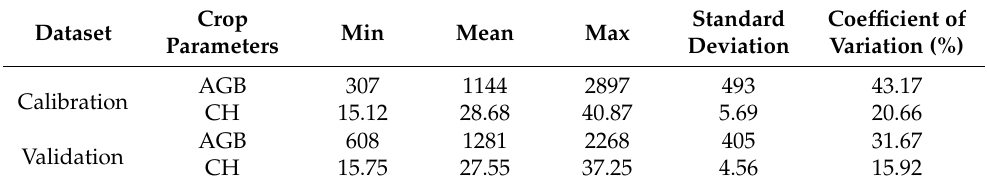
Table 2. Descriptive statistics for AGB (kg/hm 2 ) and CH (cm) of calibration and validation datasets.